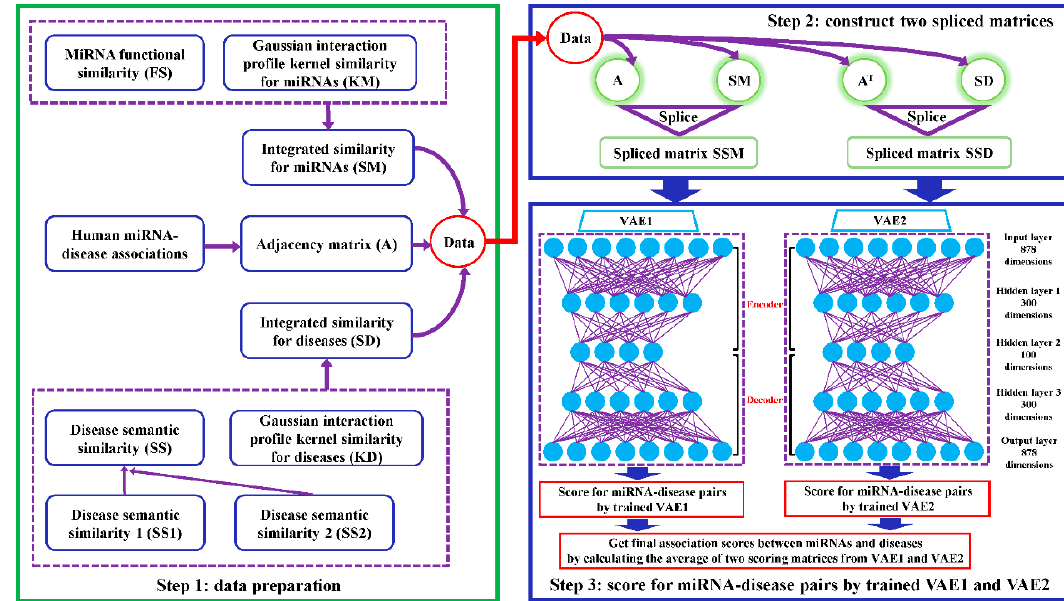
Figure 1. Flowchart of potential miRNA–disease association prediction based on the computational model of VAEMDA: (1) Data preparation, where integrated similarity for miRNAs / diseases ( SM / SD ) were calculated and the adjacency matrix A representing human miRNA–disease associations was constructed. (2) Construct two spliced matrices, where adjacency matrix A and integrated similarity matrix SM for miRNAs were spliced into matrix SSM . At the same time, adjacency matrix A T and integrated similarity matrix SD for diseases were spliced into matrix SSD . (3) Score for miRNA–disease pairs by trained VAE1 and trained VAE2, where spliced matrix SSM and spliced matrix SSD were applied to train VAE1 and VAE2, respectively. We calculated the average of two scoring matrices to obtain final association scores between miRNAs and diseases.